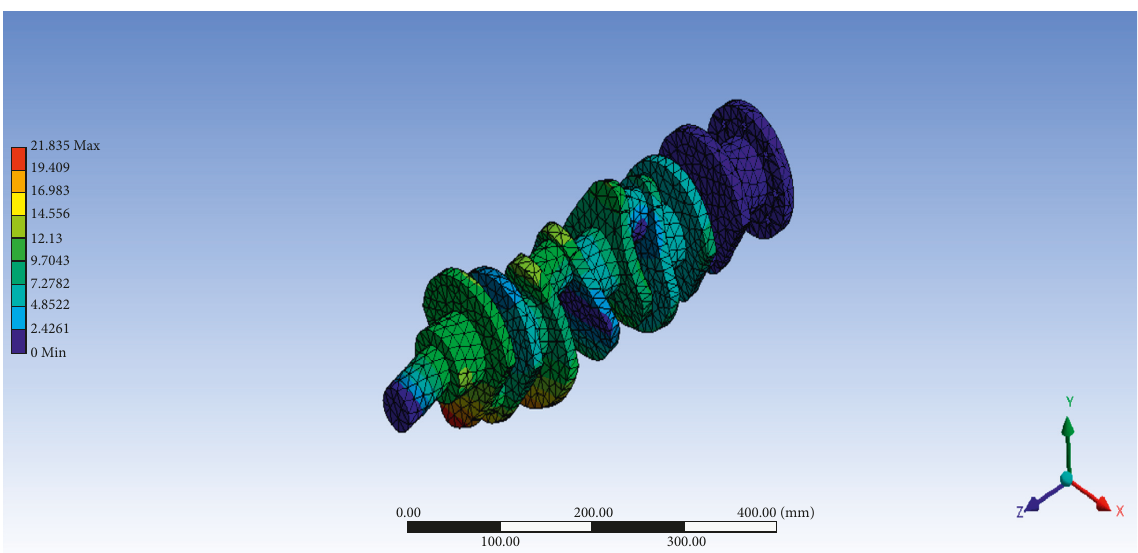
Figure 15: Deformation of carbon fiber composite crankshaft at the fifth mode of